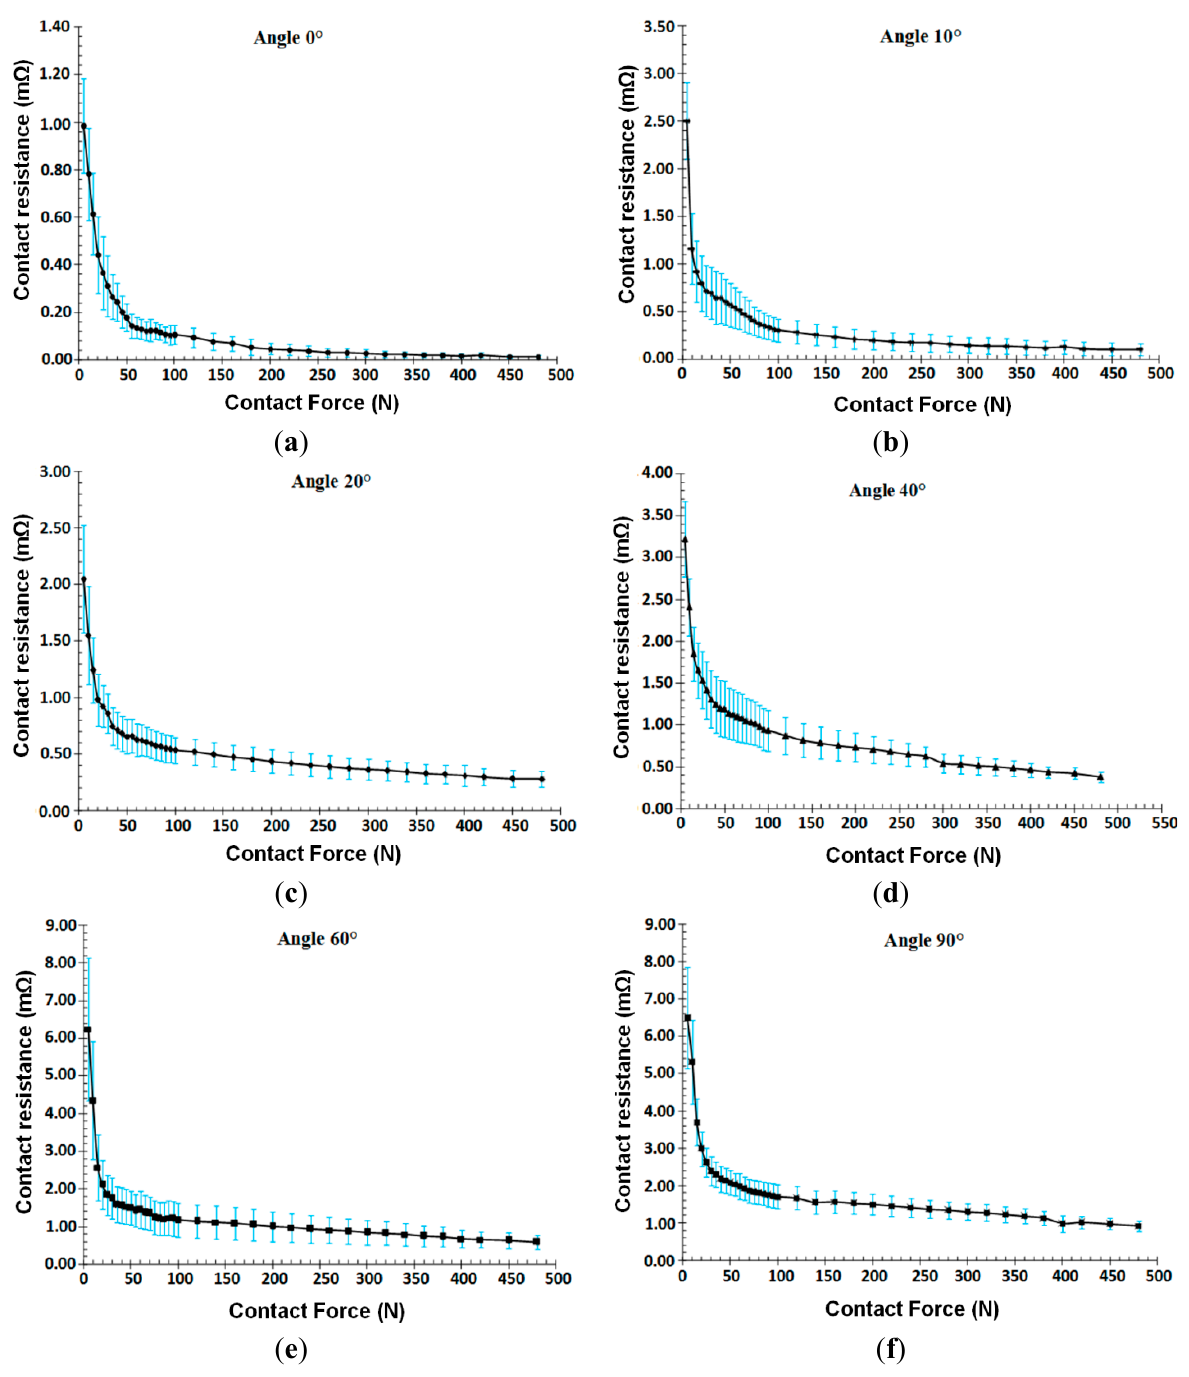
Figure 4. Resistance of the contact area according to the angle between the crossed wires, diameter of wire 1.8